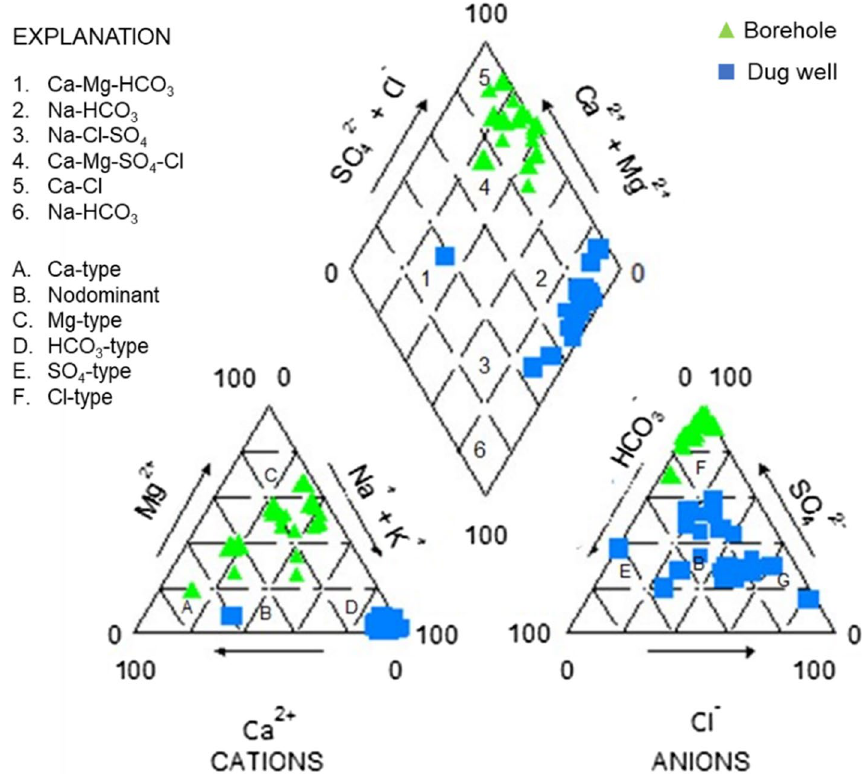
the chemical composition of shallow and deep